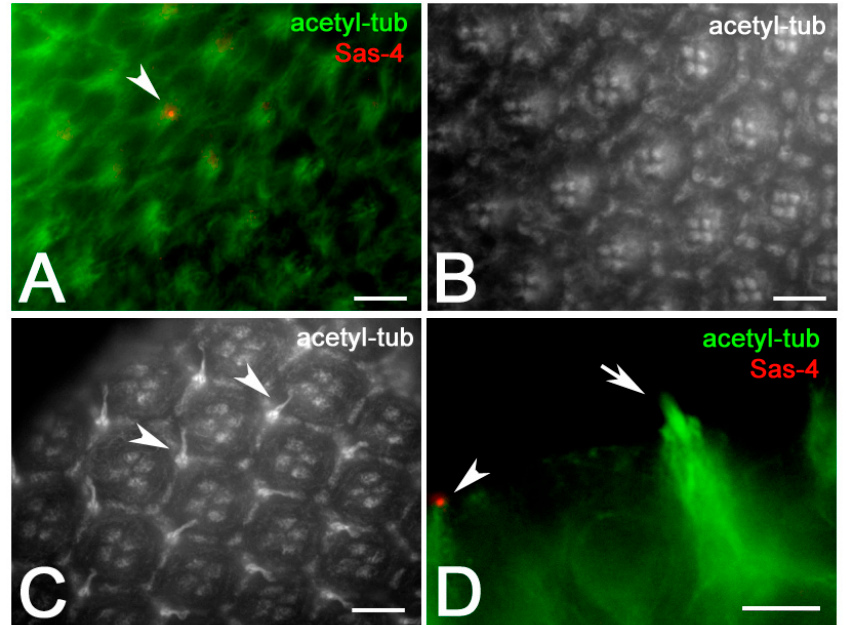
Figure 7. Organization of the pupal retina in Sas-4 mutants. ( A ) Only one centriole (arrowhead) is seen within the ommatidial cells of this young pupal imaginal disc. Surface views of the pupal retina at 25 h ( B ) and 45 h ( C ) APF: the ommatidia have an overall wild-type organization and distinct mechanosensory bristles are visible at the apex of each ommatidial unit (arrowheads). ( D ) Lateral view of a mechanosensory bristle (arrow): the only centriole observed within this field (arrowhead) is far from the bristle. Scale bars: 10 µm ( A – C ), 2.5 µm ( D ).